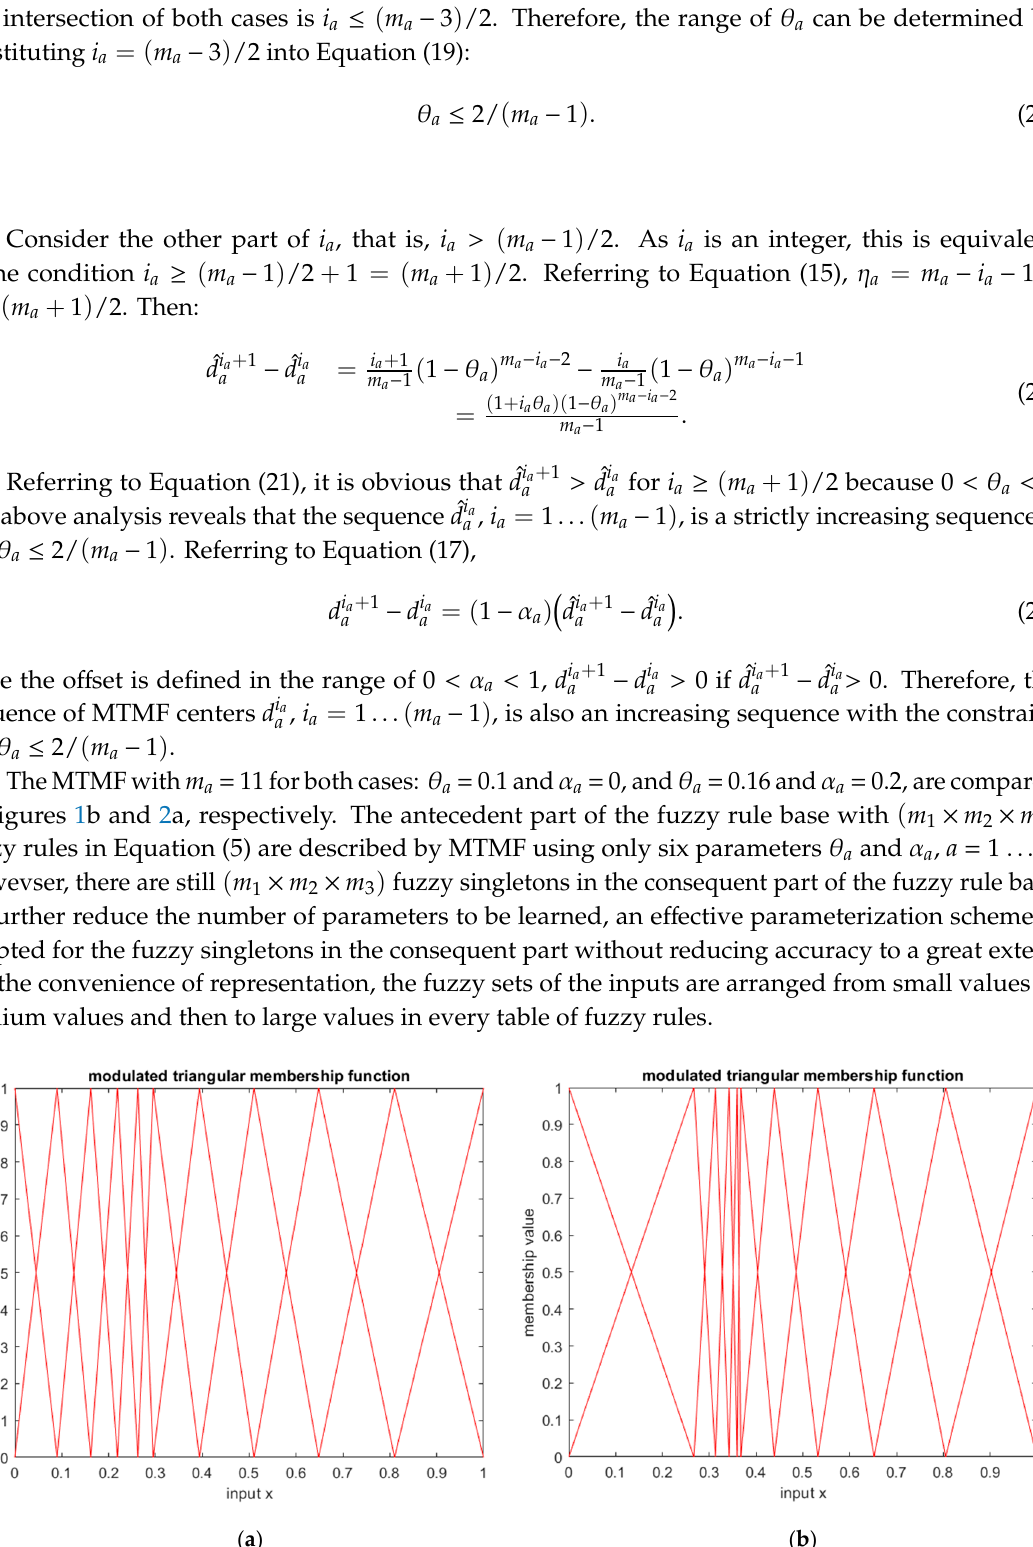
Figure 2. Illustration of modulated triangular membership functions with m a = 11 and ( a ) θ a = 0.1, α a = 0; ( b ) θ = 0.16, α = 0.2.